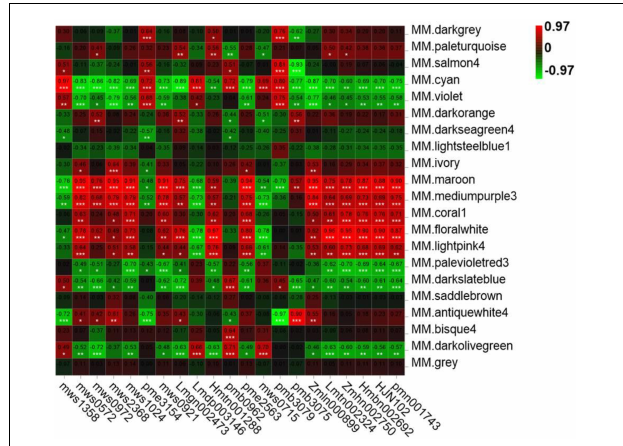
FIGURE 10 | Module-trait associations based on Person correlations. The color key from green to red represents γ 2 values from –0.97 to